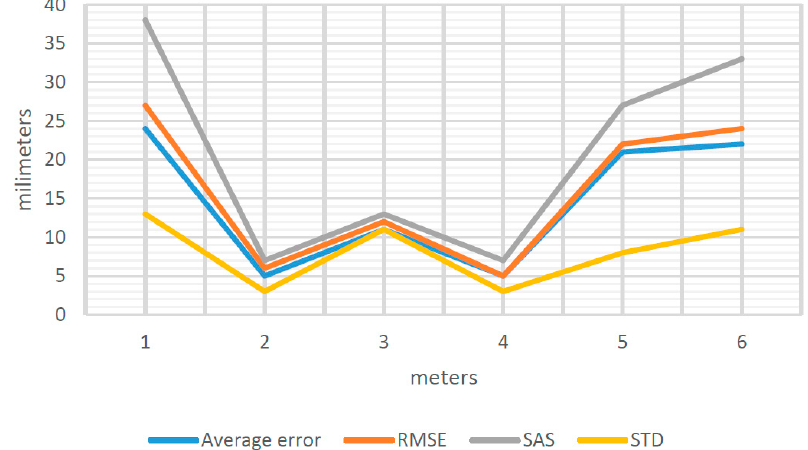
Figure 8. Average error, RMSE, SAS and STD for 1–6 m.